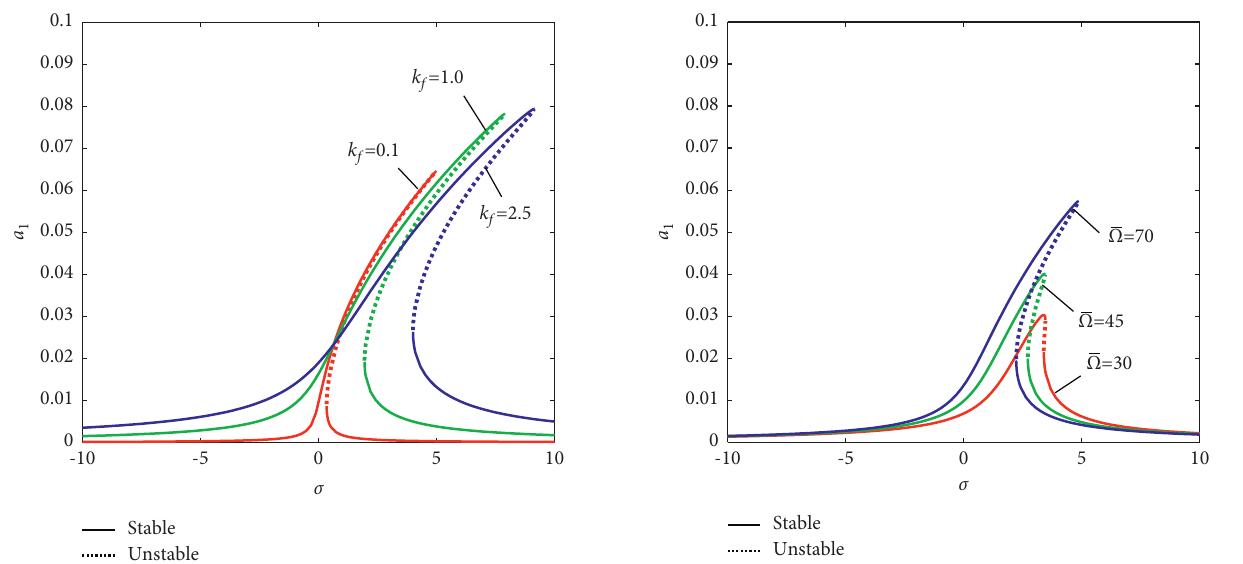
Figure 7: The effect of cutting force coefficient on frequency re- sponse curve (L/d � 10, c � 0.01, θ � 0 ° , case I).